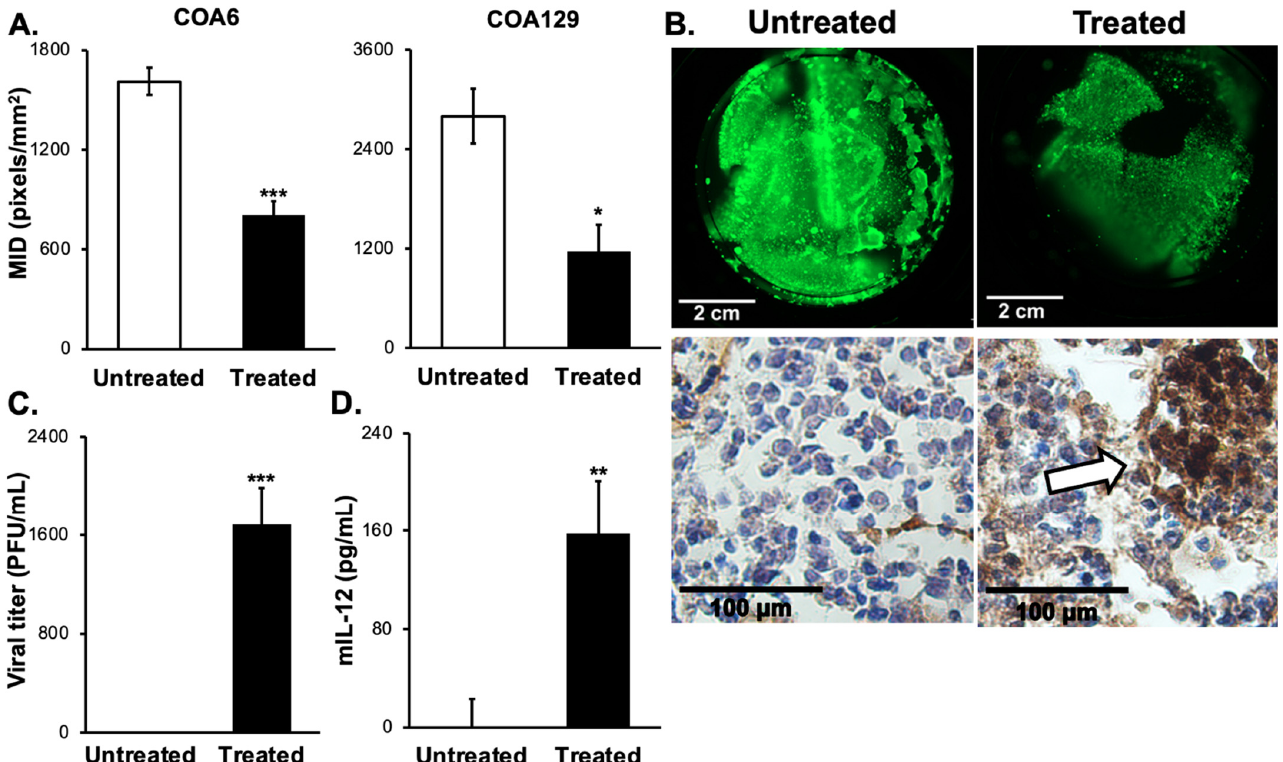
Figure 4. M002 effectively infected, replicated in, and killed neuroblastoma PDX cells ex vivo. ( A ) 3D printed tumors of a high-risk neuroblastoma PDX (COA6) and low-risk MS neuroblastoma (CO129) were used. COA6 and COA129 microtumors were given intratumoral injections of M002 (n = 4, MOI 10 7 /10 µL in sterile PBS) or control (n = 4, 10 µL of sterile PBS). Following one week of infection, tumors were stained with calcein AM to detect viable tumor tissue (viability indicated by green, fluorescent staining) and analyzed with ImageJ to determine the mean integrated density (MID, pixels/mm 2 ) for treated versus untreated tumors. Graphs indicating the significant decrease in MID for COA6 and COA129 are shown, representing the significantly decreased viability (* p ≤ 0.05, *** p ≤ 0.001, treated vs. untreated). ( B ) Representative fluorescent photomicrographs of calcein AM stained COA6 untreated (top left panel) and treated (top right panel), scale bars represent 2 cm. COA6 microtumors were stained using immunohistochemistry for HSV (bottom panels). There was no HSV staining detected in the untreated microtumor (bottom left panel), but M002-treated microtumors showed positive staining for HSV (brown staining, white arrow, bottom right panel), scale bars represent 100 µm. ( C , D ) Media surrounding the microtumors were collected to assess for the presence of M002 and mIL-12 in the tumor microenvironment. Neither M002 nor mIL-12 was detected in the media of any COA129 microtumors, but there was a significant amount of ( C ) M002 progeny virions and ( D ) soluble mIL-12 detected in the media surrounding the COA6 microtumors (** p ≤ 0.01, *** p ≤ 0.001, treated vs. untreated). A Student’s t -test was used for statistical analysis. Since the M002 was injected directly into the microtumors and not into the media, we determined if progeny virions could be detected in the media as indirect evidence of viral replication and to quantify the amount of M002 in the tumor microenvironment capable of infecting surrounding tumor cells. The media surrounding the microtumors was collected and viral titer plaque assays performed. At 120 h post injection, progeny virions were detected in the media (Figure 4C) of only the COA6 tumors. Next, we sought to quantify mIL-12 in the media of these microtumors. Similar to viral progeny, at 120 h the COA6 microtumors produced a significant amount of mIL-12 in comparison to the COA129 microtumors (Figure 4D). 4. Discussion